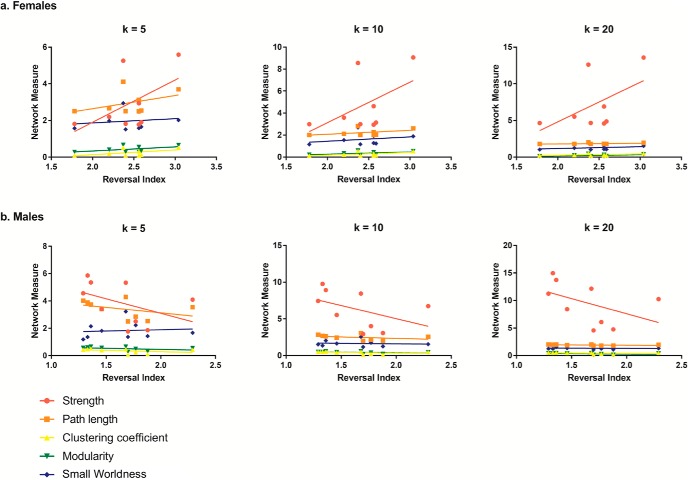
Functional network strength is positively correlated with cognitive performance in females and negatively correlated in males. A, Linear regression between RI and several network measures (strength, path length, clustering, modularity, small worldness) indicates a positive correlation between only node strength and RI. B, Similar to females, only node strength covaries with RI values. However, in males, this is observed as a negative correlation; k values represent different connectivity density thresholds.